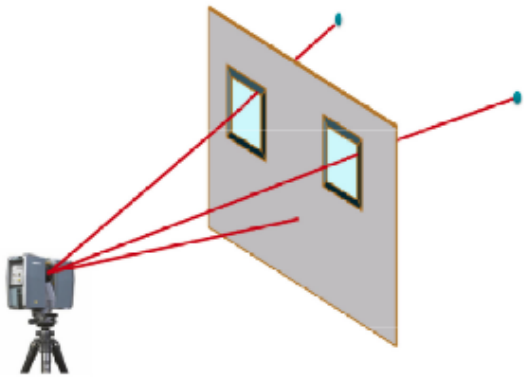
Figure 9. LiDAR rays that pass through windows. 3D points cloud (N points )